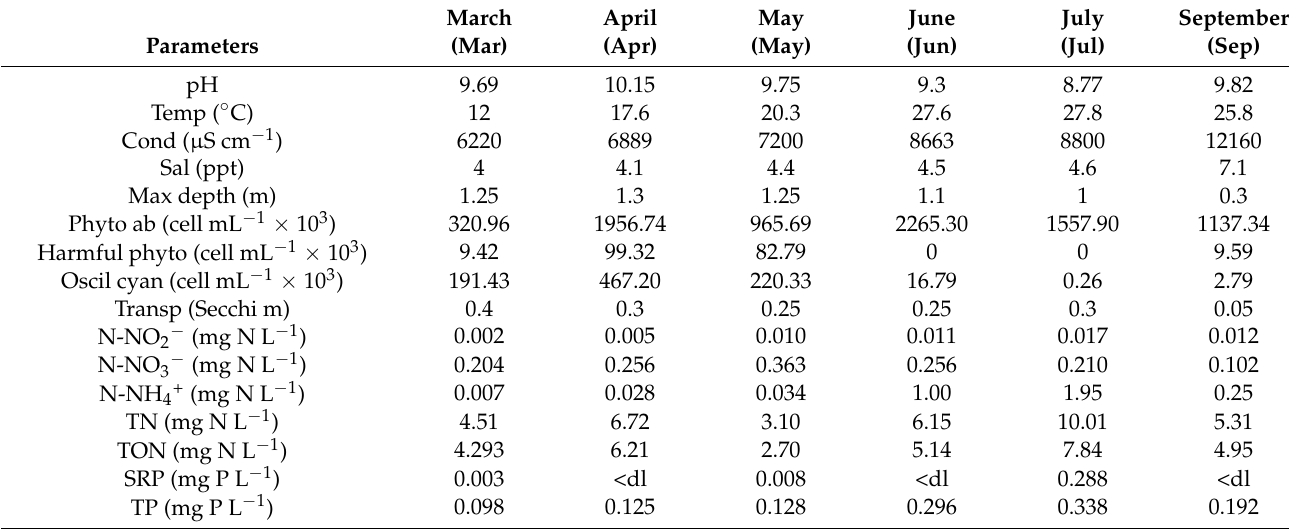
Table 1. Physicochemical parameters and phytoplankton abundance measured in the water column from Lake Koronia during the study period (March to September